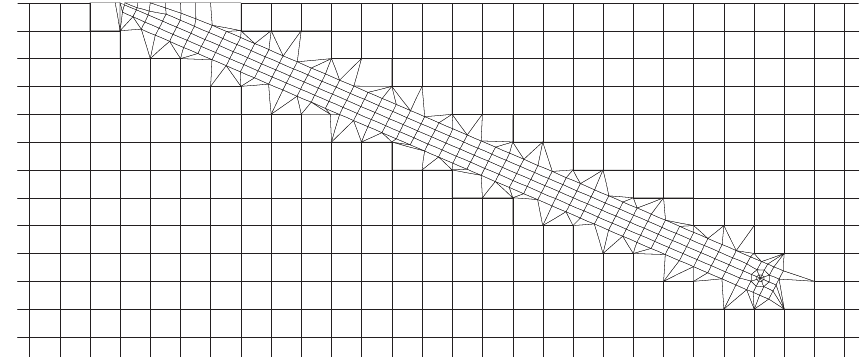
Figure 3: Part of the FEM mesh showing the way the crack vicinity is divided into finite elements. The grid used in flow analysis is the same as boundary FEM nodes